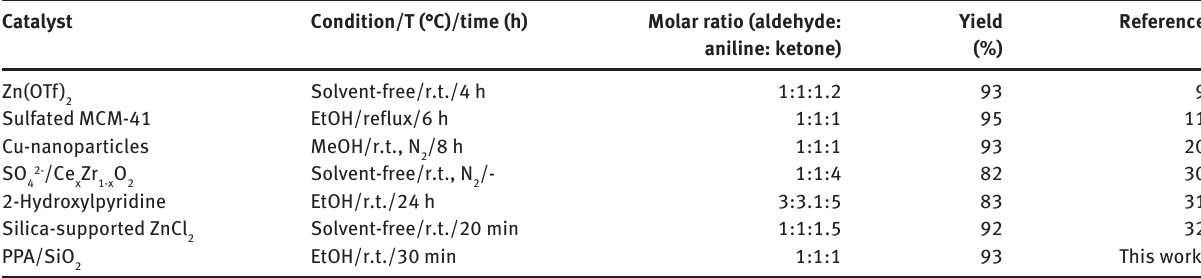
Table 4 Comparison of the efficiencies of various catalysts used in the synthesis of 2-[phenyl(phenylamino)methyl]cyclohexanone. Catalyst Condition/T ( ° C)/time (h) Molar ratio (aldehyde: aniline: